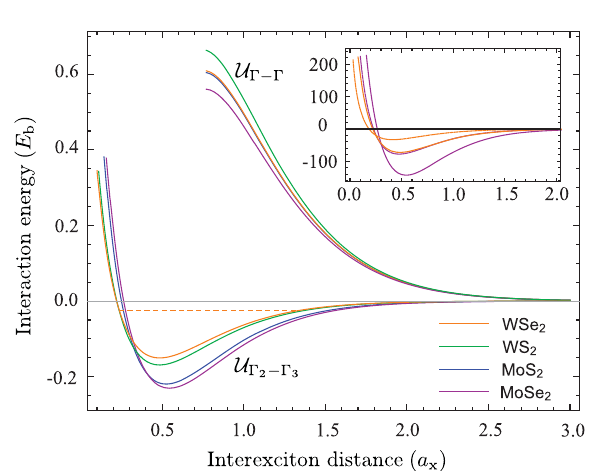
Fig. 3 Intravalley and intervalley exciton interaction potential in the limit of vanishing momentum transfer in freestanding ML TMDs. The dashed line inside the intervalley potential in ML WSe 2 depicts the approximate position of the intervalley biexciton